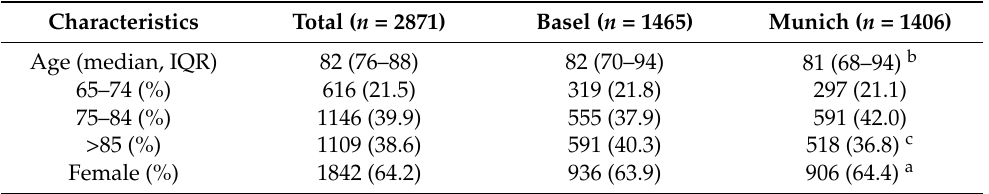
Figure 1. Inclusion and exclusion flow diagram of patient selection from 1 January 2016 to 31 December 2016 in Basel and Munich, with patients receiving computed tomography (CT) examinations of the head, spine, chest, abdomen, pelvic ring or proximal long bones during emergency department presentation or within 48 h. Table 1. Baseline characteristics of 2871 elderly adult patients presenting with low-energy falls from 1 January 2016 to 31 December 2016.